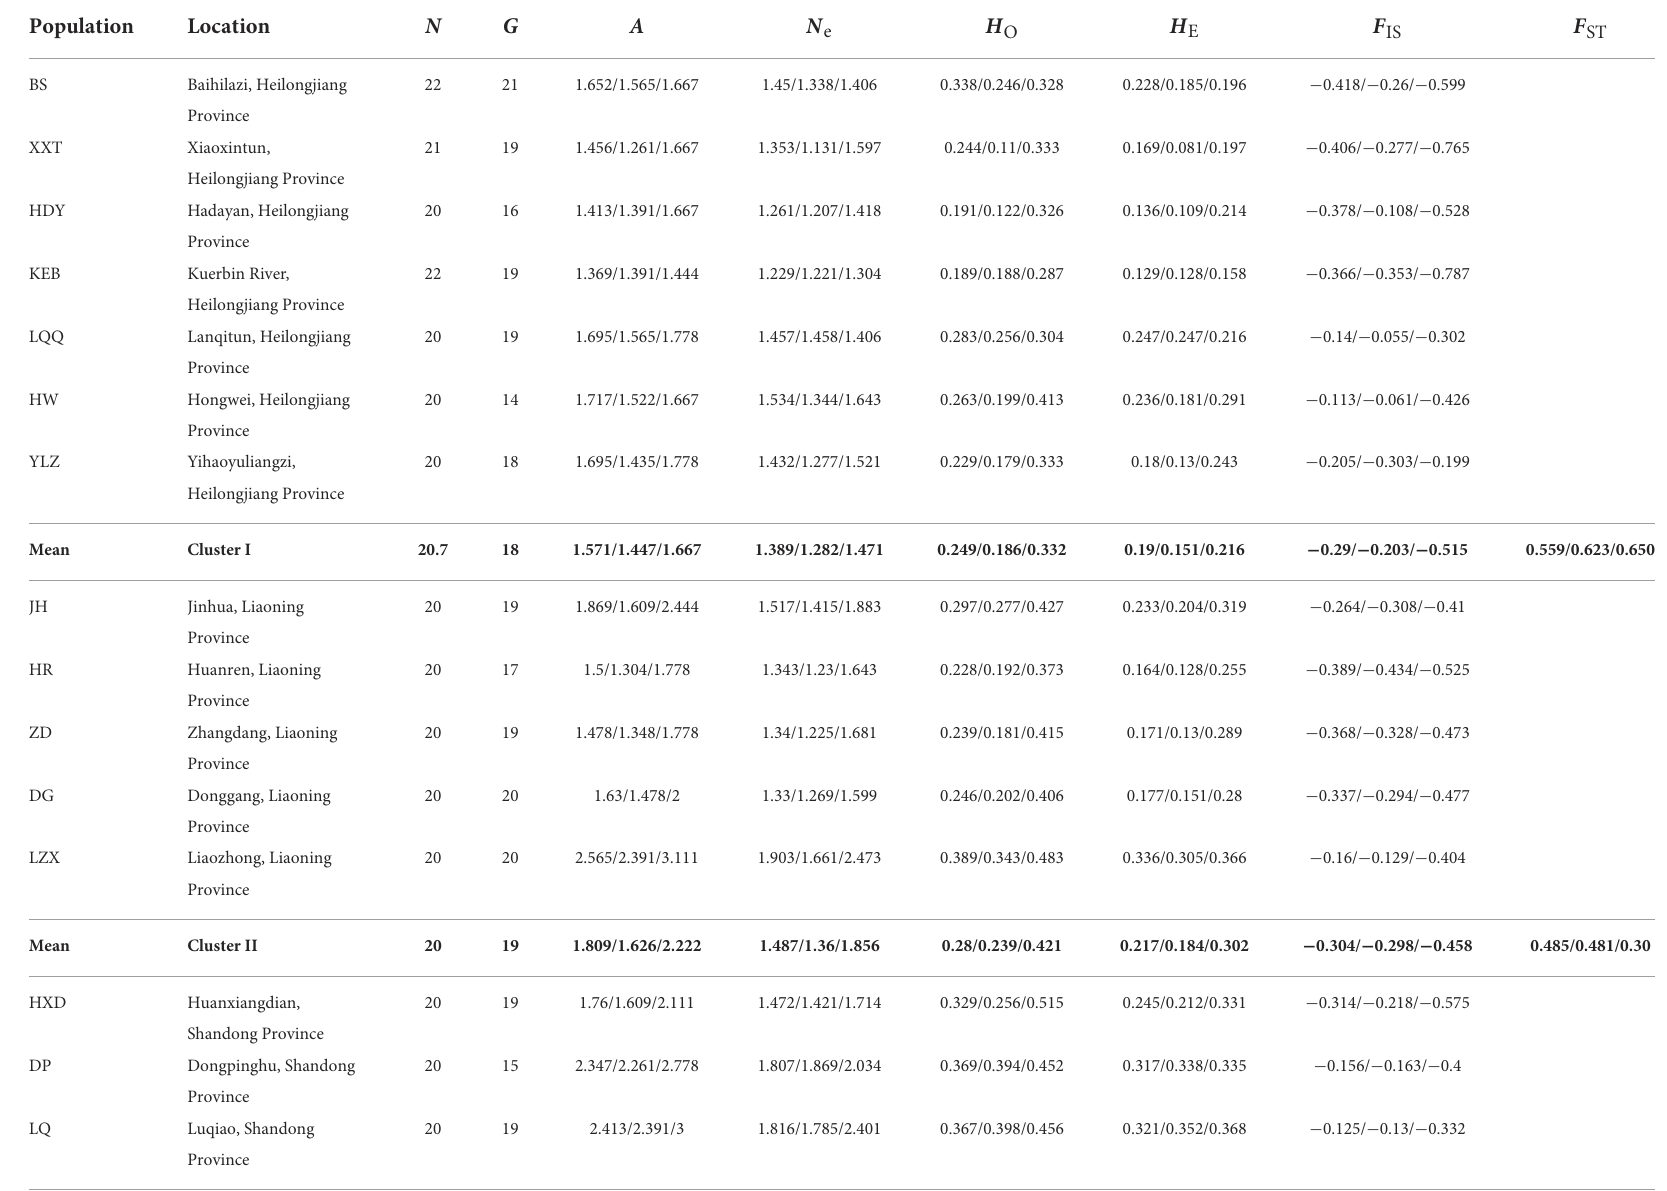
TABLE 1 Geographical information and summary of genetic diversity measures for 28 Zizania latifolia populations based on 46 simple-sequence repeat (SSR) loci/23 neutral loci/9 outlier loci. Population